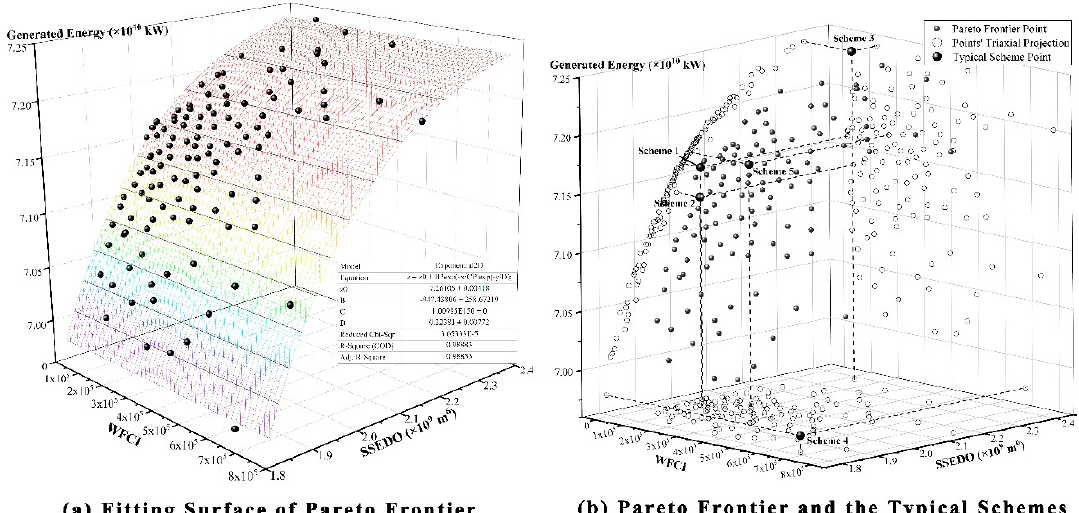
Figure 6. The Pareto frontier of VA-NSGA-III.